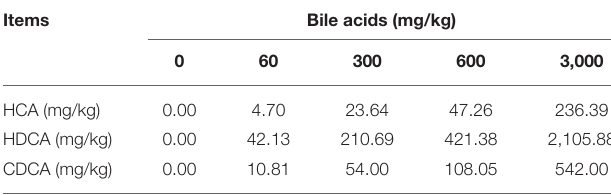
TABLE 2 | Bile acids content in each treatment